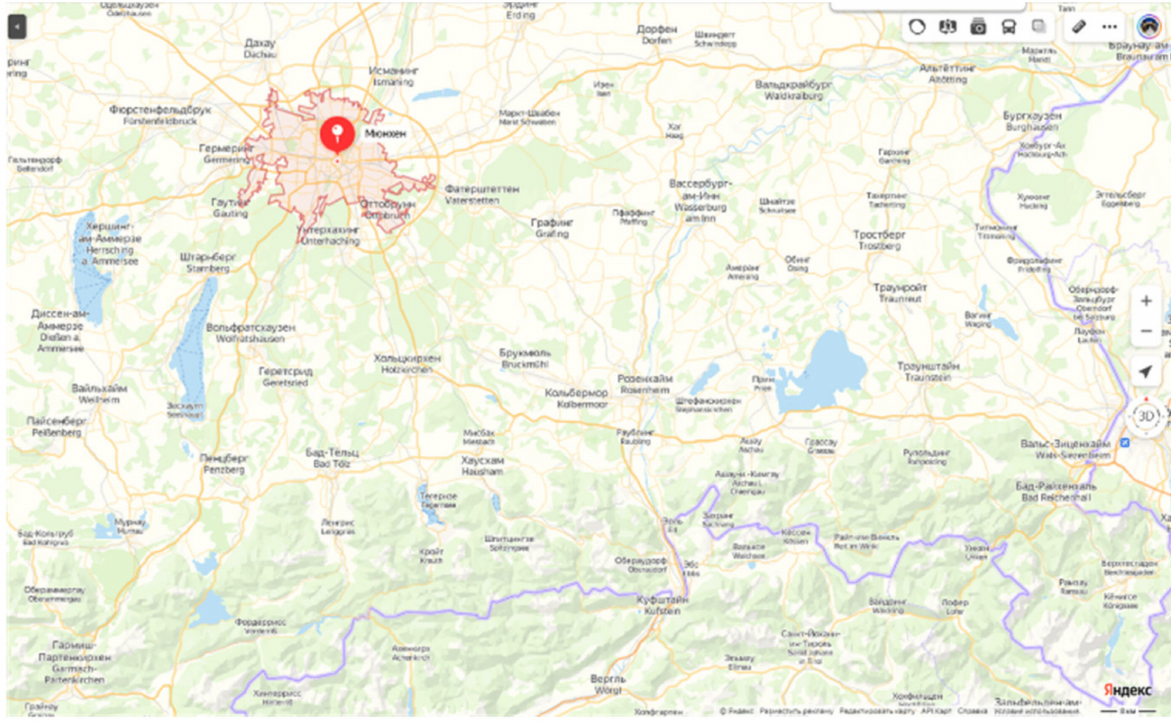
Figure A1. Due to heavy rains since 12 July 2021, the tributaries of the Rhine Ar and Moselle, as well as several smaller rivers, have overflowed their banks in the west and southwest of Germany. The main impact of these elements fell on the lands of North Rhine-Westphalia and